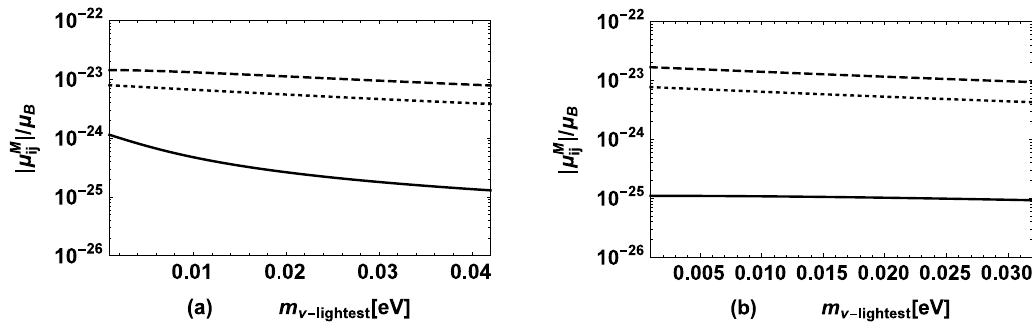
Figure 8 . | µ M | /µ B versus m ν − lightest are plotted for NH (a) and IH (b) neutrino mass, where the ij solid, dotted, dashed lines denotes the results of | µ M